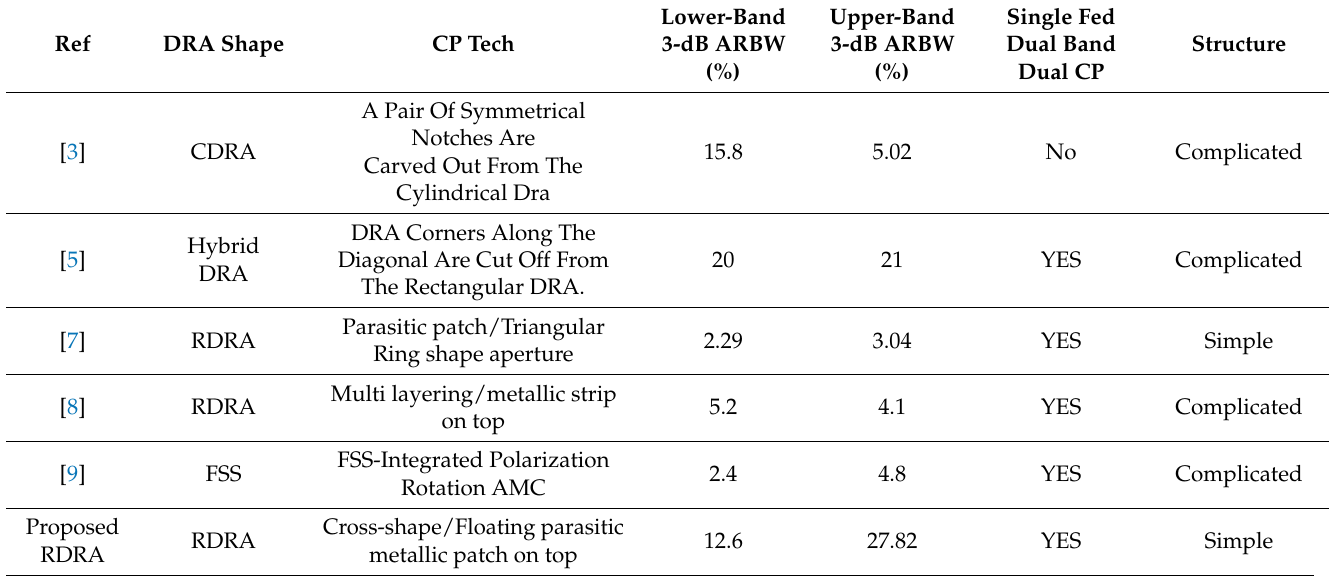
Table 4. Comparison between the proposed Antenna and other Antennas (Dual CP) (Frequency unit: